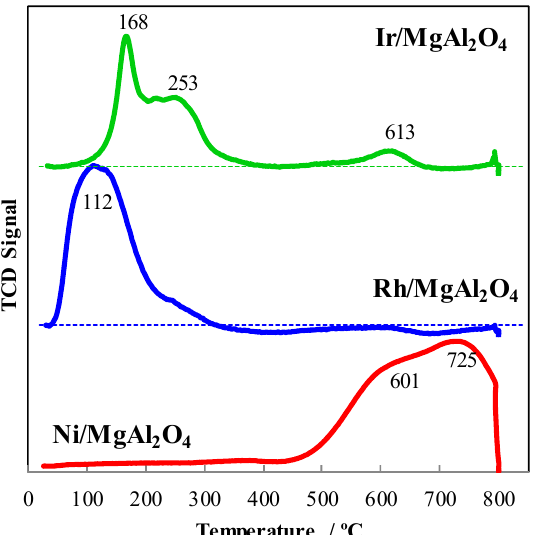
Figure 1. Temperature programmed reduction (TPR) profiles for MgAl 2 O 4 -supported Ir, Rh, and Ni catalysts. Prior to TPR the catalysts were calcined at 500 ◦ C for 4 h. TPR conditions were 50 mg of catalyst, temperature ramping rate 5 ◦ C / min, feed rate of 50 mL / min of 5% H 2 / Ar gas. H 2 activation, adsorption strength relative to carbon, and coverage on metal surfaces are important metrics for steam reforming relevant reactions [33,41,46]. However, obtaining accurate